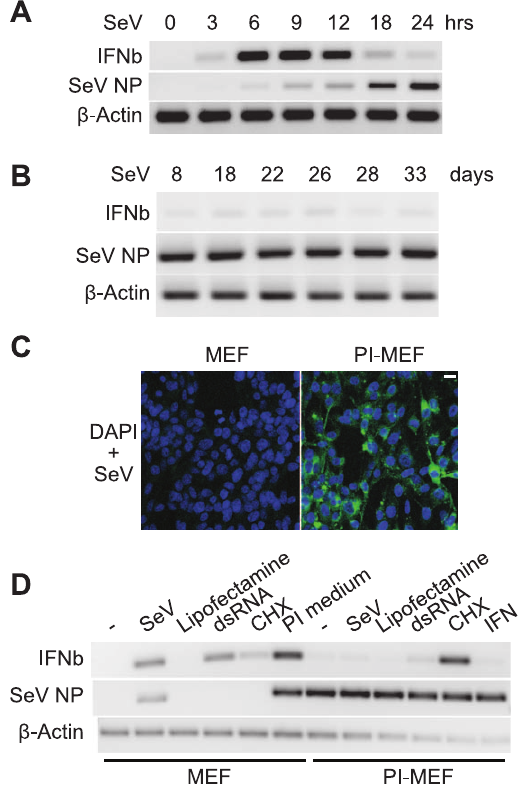
Figure 2. Establishment of persistent SeV infection in MEFs. A . The kinetics of IFN b expression and virus replication during acute SeV infection. MEFs were infected with SeV and incubated for the indicated times, total RNA was prepared, and the expression of IFN b , SeV NP and b -Actin monitored by RT-PCR. B . SeV establishes a persistent infection in MEFs. MEFs infected by SeV for 8 to 33 days were harvested, and total RNA extracted. The expression of viral NP and the IFN b gene was analyzed by RT-PCR. C . SeV is present in all PI-MEFs. Control MEFs or PI- MEFs were fixed and subjected to immunofluorescent staining with an anti-SeV antibody (green). Blue: DAPI staining for nuclei. Scale bar, 20 m m. D . Negative regulation of IFN b expression in PI-MEFs. Control MEFs or PI-MEFs were subjected to a new dose of SeV infection, double strand RNA (dsRNA, poly I:C) transfection or CHX (50 m g/ml) for 6 hrs, control MEFs were also treated with culture medium from PI-MEFs for 6 hrs, and PI-MEFs were treated with recombinant IFN b protein (1000 U/ml) for the same length of time, total RNAs were prepared and the expression of IFN b , SeV NP and b -Actin were analyzed by RT-